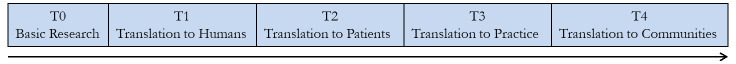
The translational research spectrum.